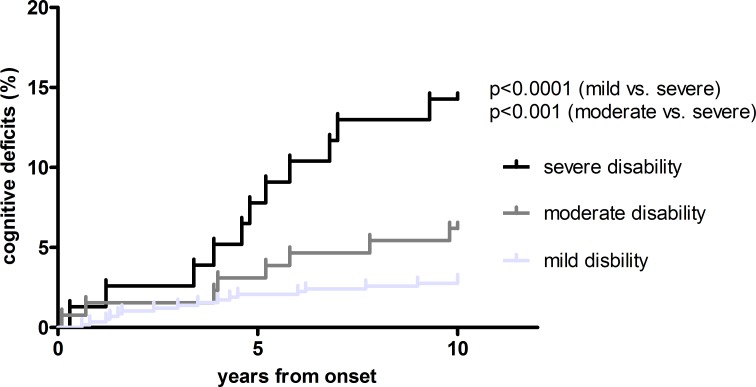
time to cognitive dysfunction.Kaplan-Meier curves of the risk of developing cognitive dysfunction according to disability status 10 years after onset. Log rank test used for calculation of significancy.